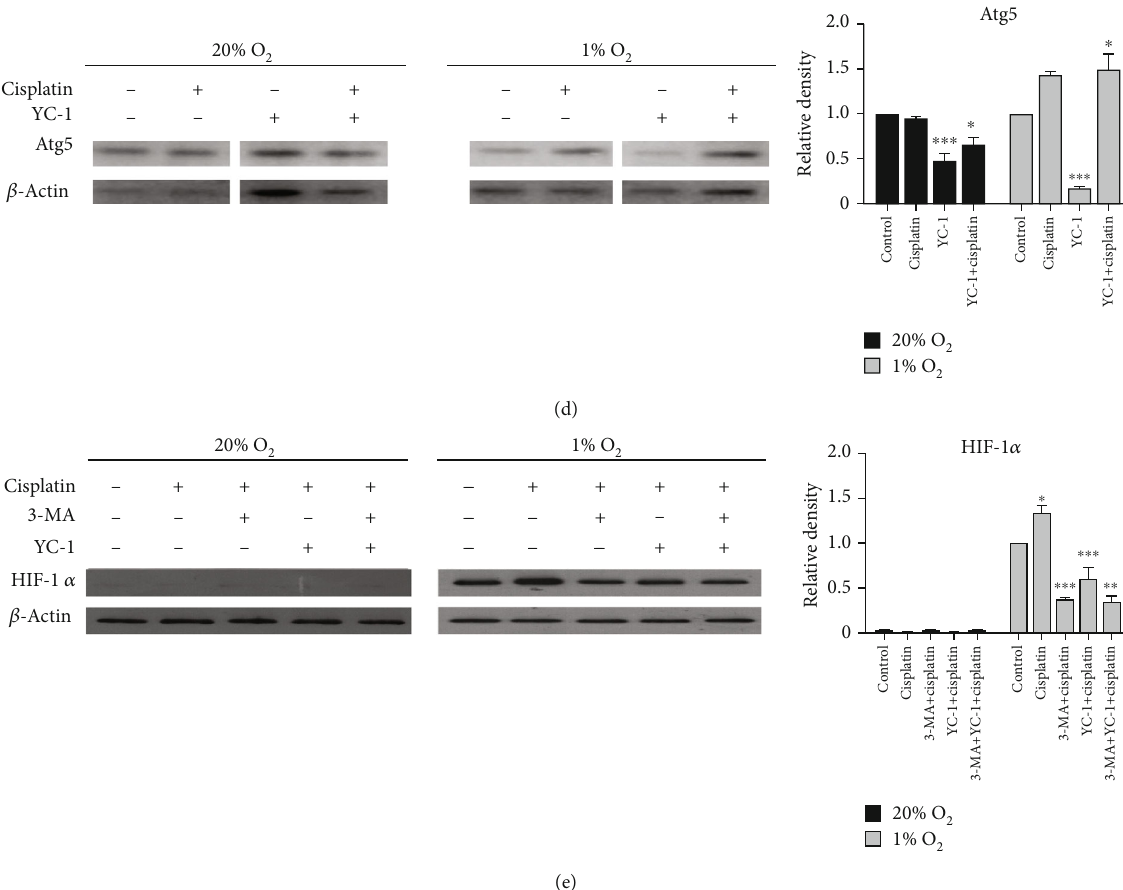
Figure 5: Expression of related marker proteins and genes under normoxic and hypoxic conditions by Western blotting. (a) Beclin-1 was measured by immunoblotting under normoxia and hypoxia. (b) Caspase-3 was measured by immunoblotting when incubated with HIF-1 α inhibitor YC-1. The results indicate that hypoxia might induce cell chemoresistance through the HIF-1 α signaling pathway. (c) Beclin-1 was measured by immunoblotting under normoxia and hypoxia. (d) Atg5 was measured by Western blotting and showed a similar trend to caspase-3. (e) HIF-1 α was measured with Western blotting. The result revealed that HIF was involved in targeting apoptosis induced by